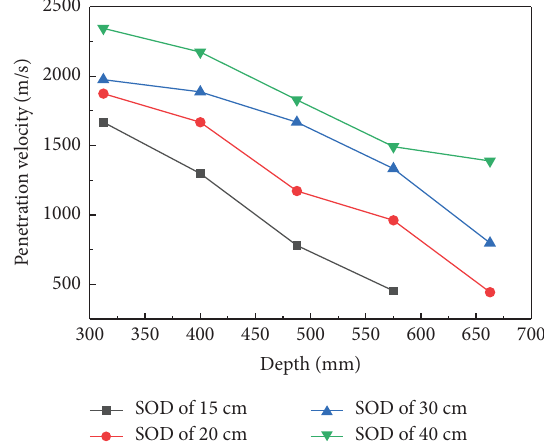
Figure 12: Test results of JPC penetration